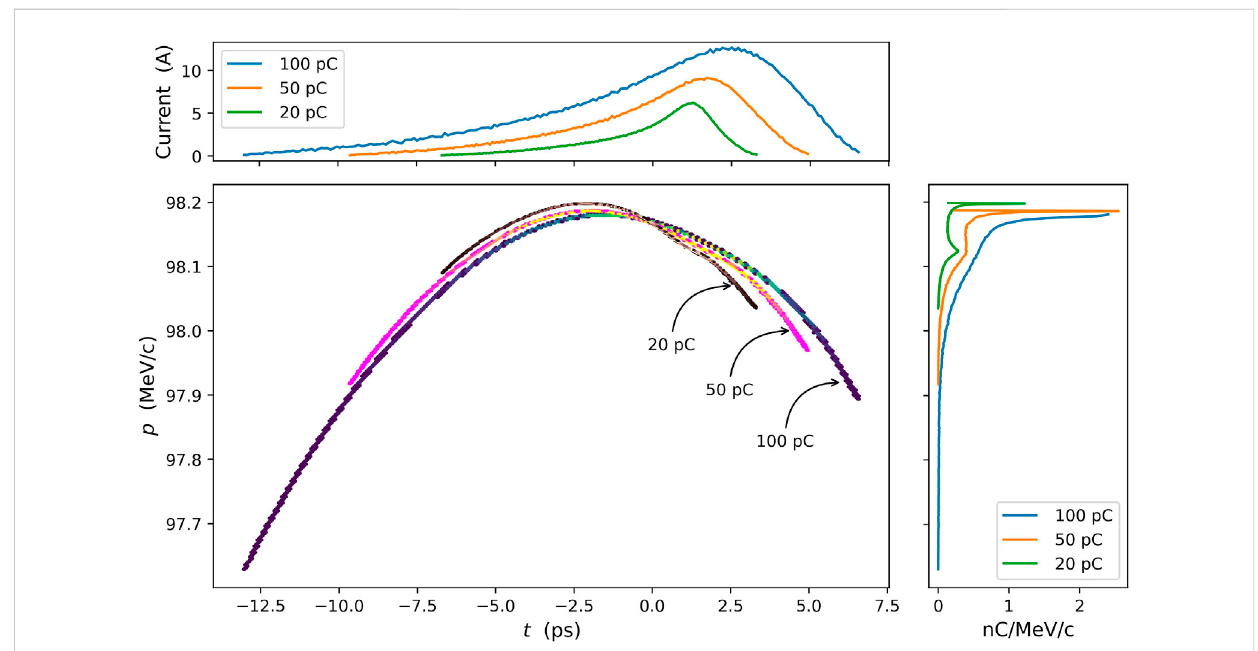
FIGURE 6 Longitudinal phase space of electron beams at the exit of photoinjector of three beam charges in the multiplexed con fi guration with customized laser spot size (case B in group I). To distinguish between each beam, we used a different color map for density representation, whichis not shown in the fi